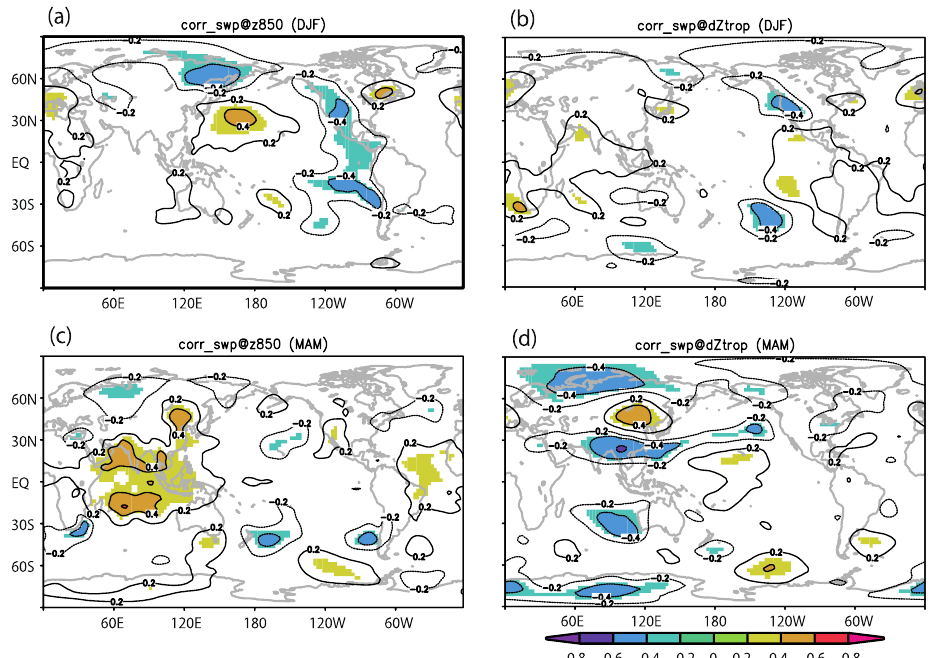
Figure 7. Same as Figure 5 but for the TCF anomaly (defined as occurrence in 5° × 5° bins, units are TCs per season) over the SWP region (averaged over 10 – 30° S, 150 – 180° E). ( a ) DJF z850, ( b ) DJF